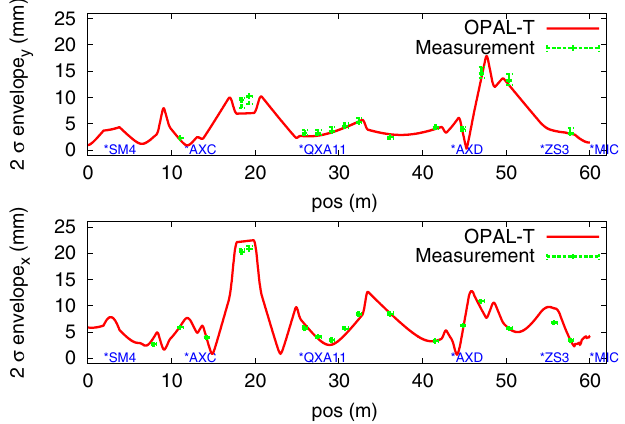
FIG. 2. Envelope of the beam in the 72 MeV transfer line for a 2 mA beam. The error bars show different measurements at the same intensity